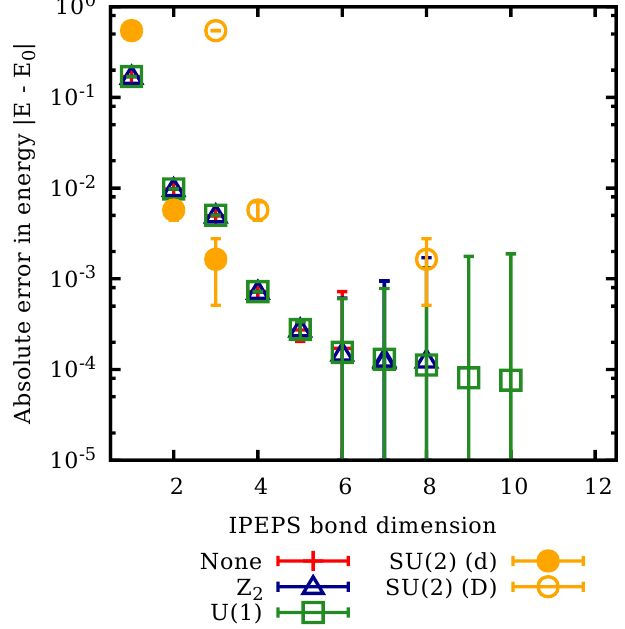
Figure 3: Error in energy per spin calculated in the Heisenberg square lattice model = − 0.669437. Error bars are obtained from the CTM calculation at ∆ = 1 with E 0 and give the error of the observable relative to its true value in the given variational